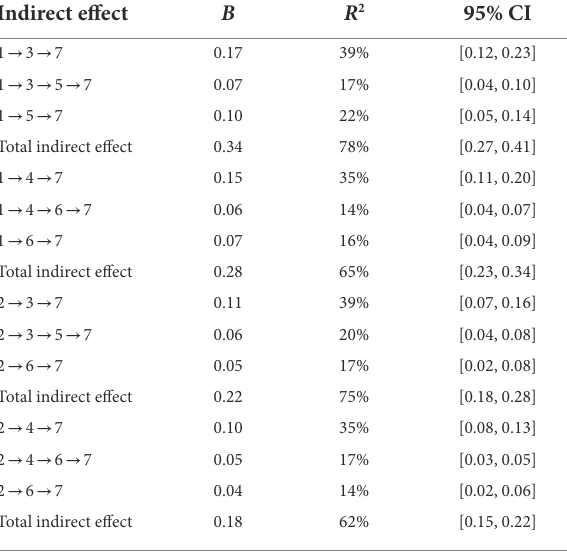
TABLE 2 Analysis of chain mediated effect ( N = 1807).